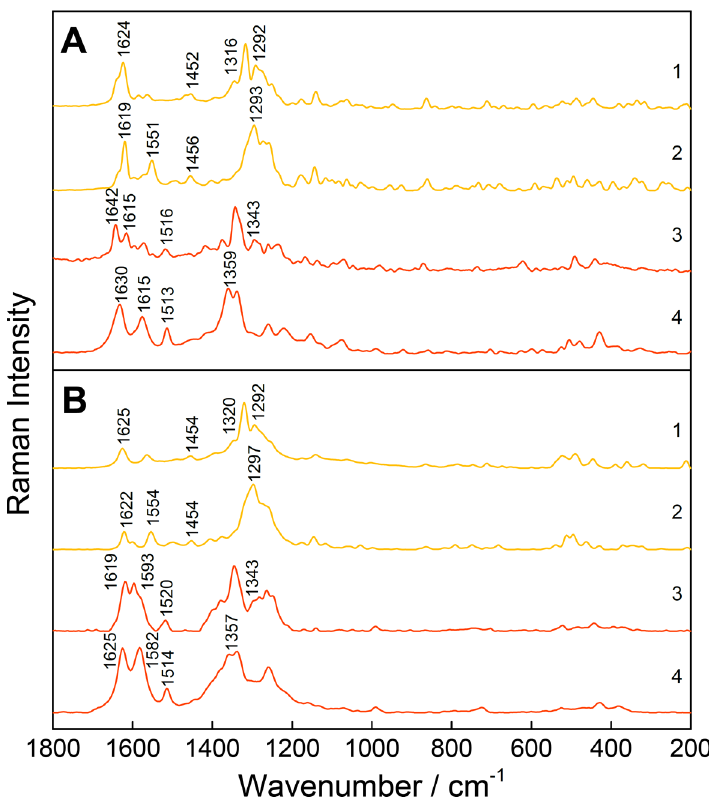
Figure 2. FT-Raman ( A ) and resonance Raman spectra ( B , λ exc = 413 nm) of TC (1), ETC (2), ATC (3) and EATC (4) in solid state. By using λ exc = 413 nm as the excitation wavelength, a relative decrease of the Raman signals of TC and ETC and a relative enhancement of the Raman bands of ATC (and EATC) was observed in the range 1550-1650 cm − 1 with respect to the highest peak, respectively. For all samples, the strongest Raman marker bands are displayed and detailed vibrational studies for TCs can be found in the literature [77,80,81]. Here, due to the different wavenumber resolution [0.96 ( A ) vs. 2.85 cm − 1 ( B )] the peak position can differ slightly.